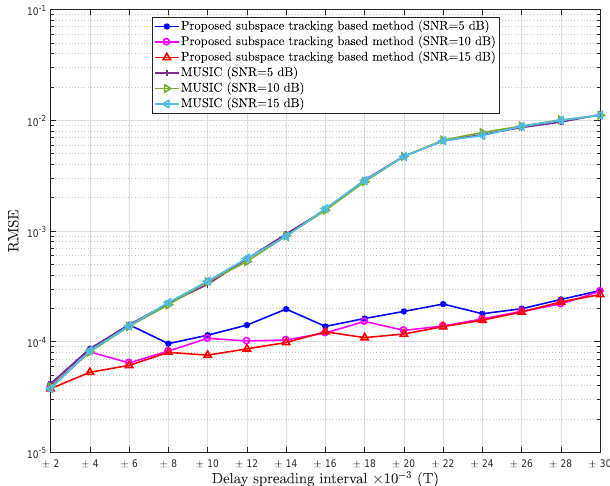
Figure 7. RMSE of mean delay estimation vs. delay spreading of the proposed subspace tracking-based method and MUSIC; P l = 20, K = 64, SNR = 5,10,15 dB.